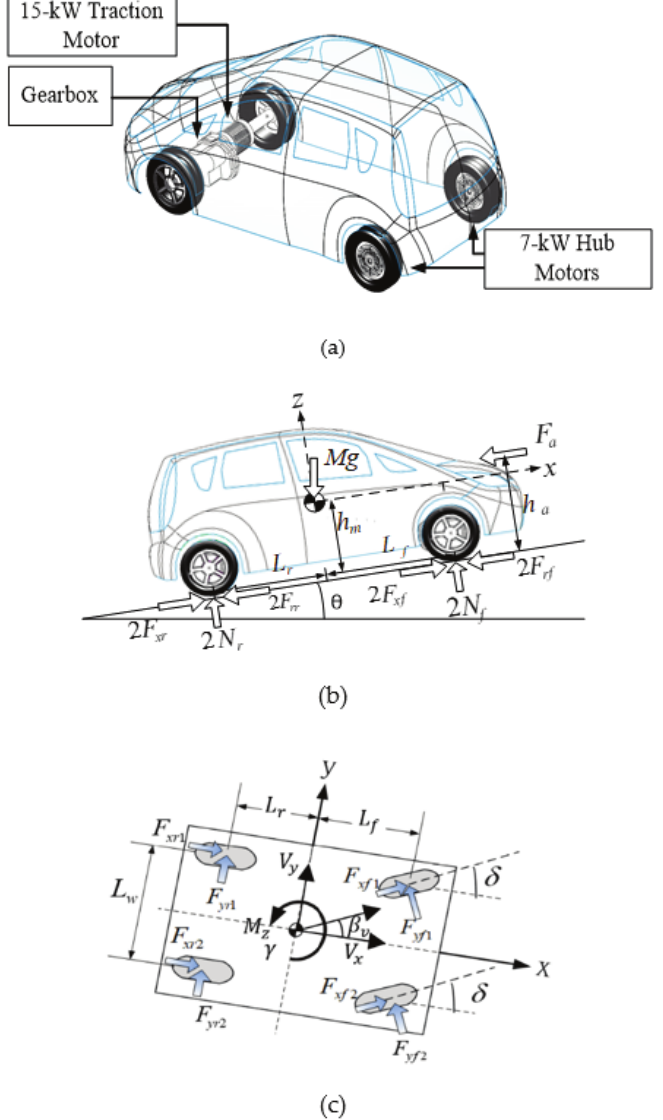
Figure 1. Electric vehicle configuration and variable definitions ( a ) propulsion system of multiple motors, and ( b ) the longitudinal and ( c ) lateral vehicle dynamics models.